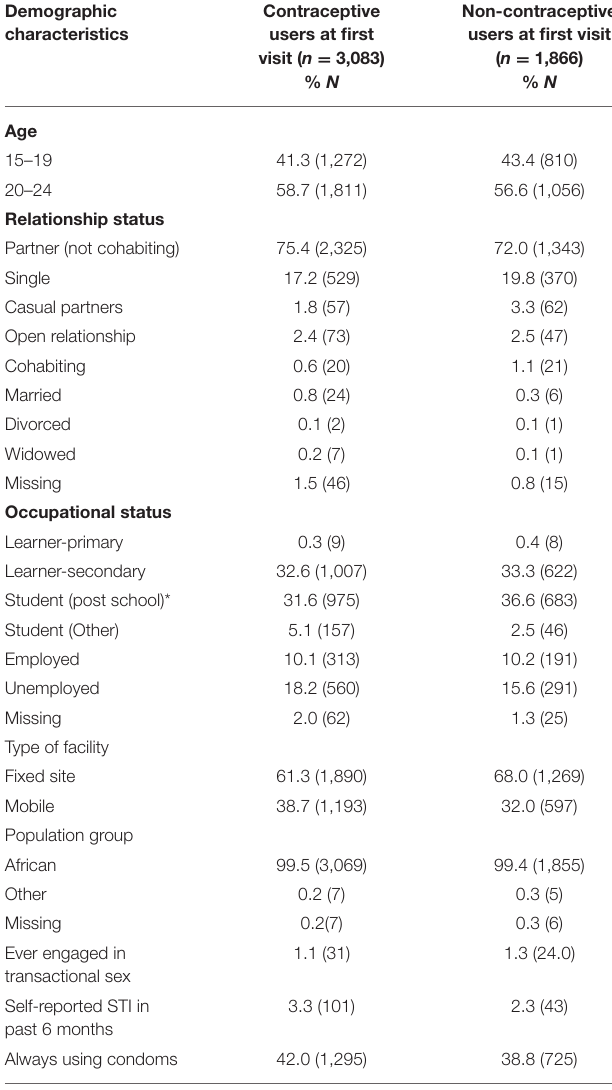
TABLE 1 | Baseline characteristics of adolescent girls and young women (AGYW) initiated on pre-exposure prophylaxis (PrEP) ( n = 4,949). Demographic